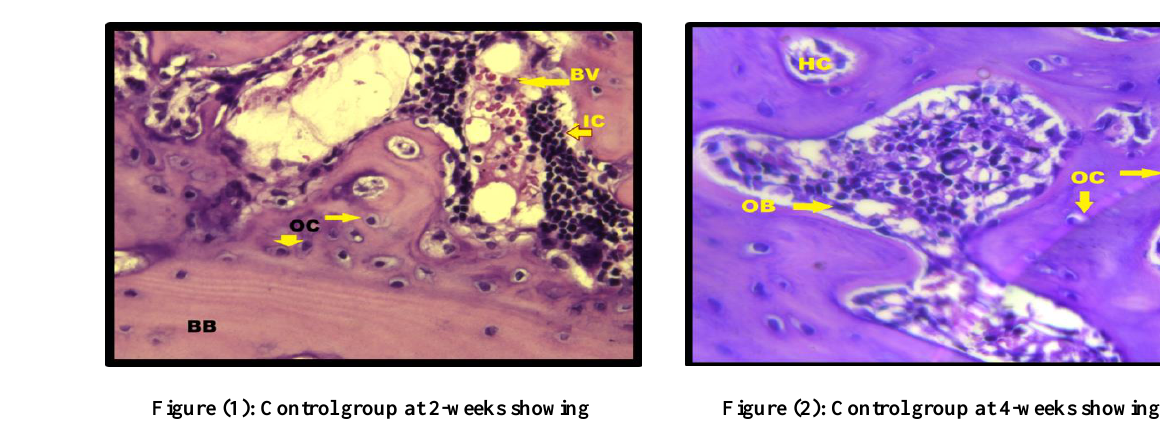
Figure (1): Control group at 2-weeks showing basal bone (BB), blood vessels (BV), inflammatory cells (IC) and osteocytes (OC). H&EX40